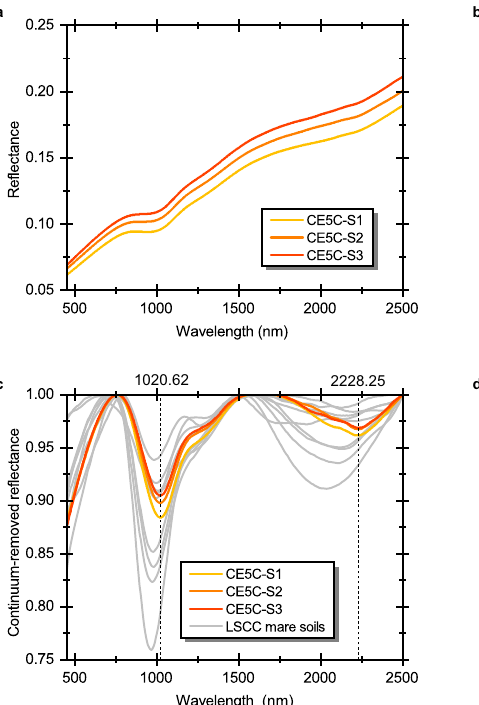
Fig. 2 | Spectral shape comparison between CE-5 and Lunar Soil Characteriza- tionConsortium(LSCC)soilsamples.a LaboratorymeasuredspectraofthreeCE- 5 lunar soil samples. b Continuum-removed spectra of CE-5 samples. c Spectra